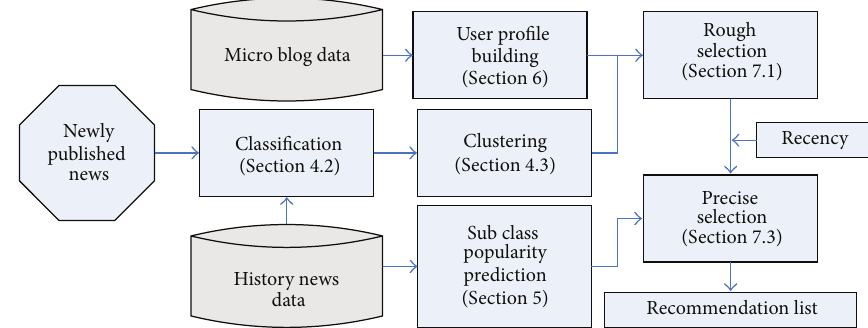
Figure 1: The overview of NEMAH framework.